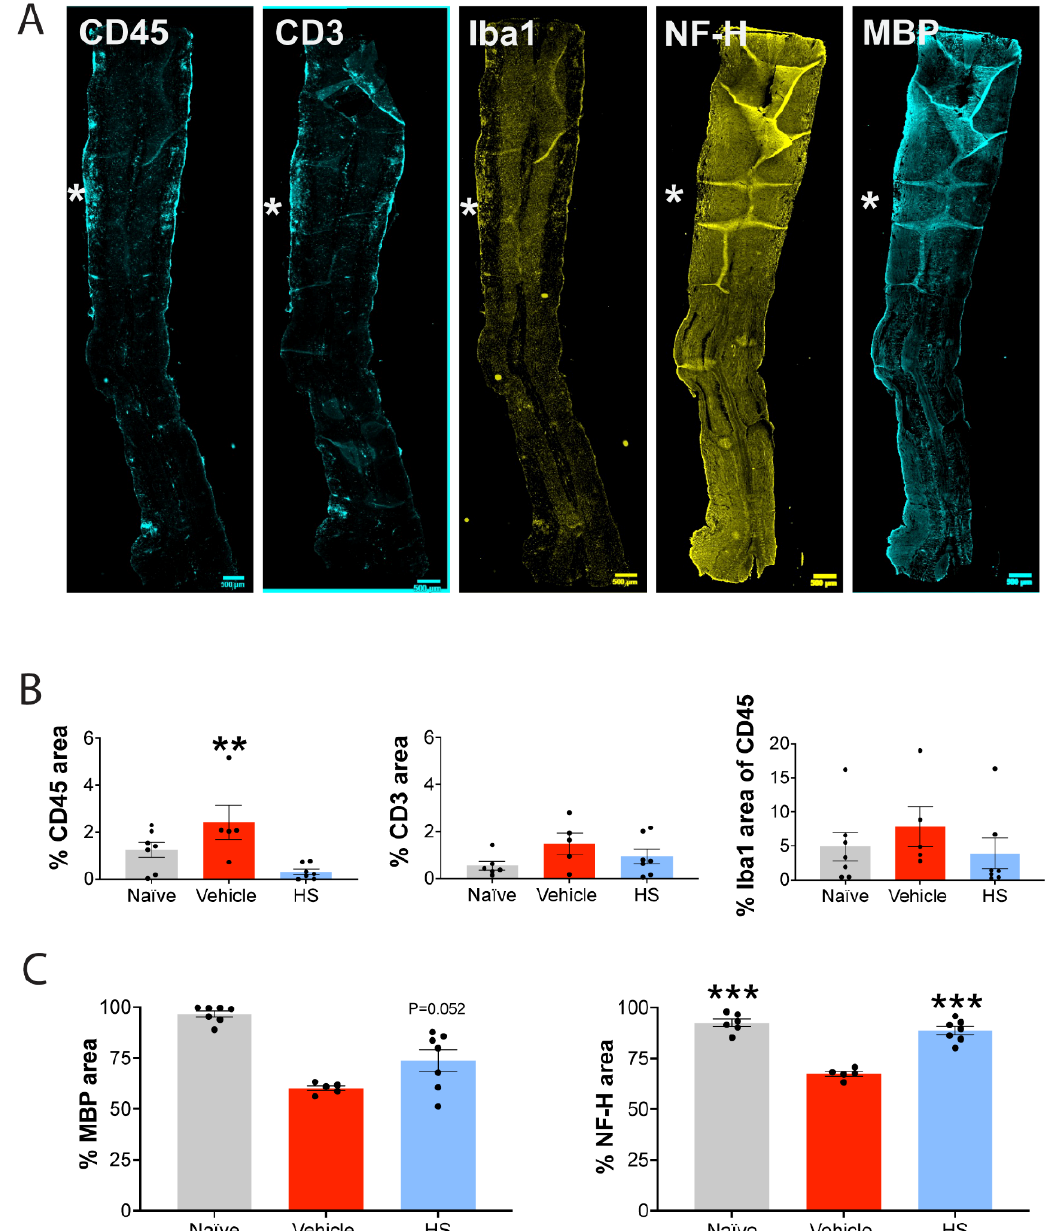
Figure 7. HS treatment prevents axonal loss in EAE. ( A ) Longitudinal thoracic spinal cord sections displayed with an active lesion indicated by *. Scale bar is 500 μ m. These longitudinal sections were used for analysis of the spinal cord covered by a particular stain. ( B ) Quantitation of the extent of neuroinflammation (CD45 for immune cells; CD3 for T cells; Iba1 for microglia/macrophage) in the spinal cords of control-EAE or HS-treated EAE mice, killed at day 24 (from the experiment of Figure 6). ** p < 0.01 (2-tail unpaired t-test). ( C ) Quantitation of the extent of myelin (MBP) and axonal (NFH) preservation in the spinal cord of EAE mice treated with HS. Naïve mice referred to as spinal cords from unmanipulated animals. *** p < 0.001 compared to EAE-vehicle control (1-way ANOVA with Dunnett multiple comparisons). 4. Discussion The neuropathology of MS includes the loss of oligodendrocytes and myelin and of neurons and their axons. The latter neuroaxonal injury and loss correlates with neurologic disability in MS, as evaluated using MRI and postmortem histology studies [76,77], and is